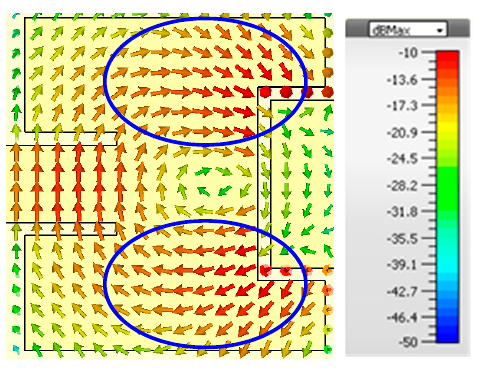
Figure 5. Simulated surface current, tangential magnetic field distributions, and the corresponding radiation patterns of the proposed dual-band patch antenna at 38.24 GHz and 59.56 GHz .